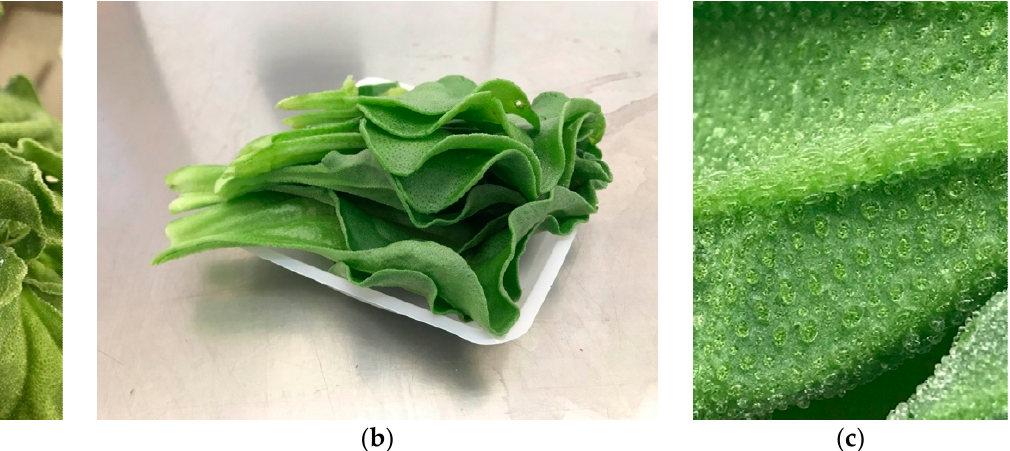
Figure 1. ( a ) Whole plant appearance of ice plant; ( b ) leaves harvested from one individual ice plant (but only leaves in the middle of the plants were sampled for consumer testing); ( c ) a close-up exhibition of epidermal bladder cells (EBCs) on the bottom side of the ice plant leaf.